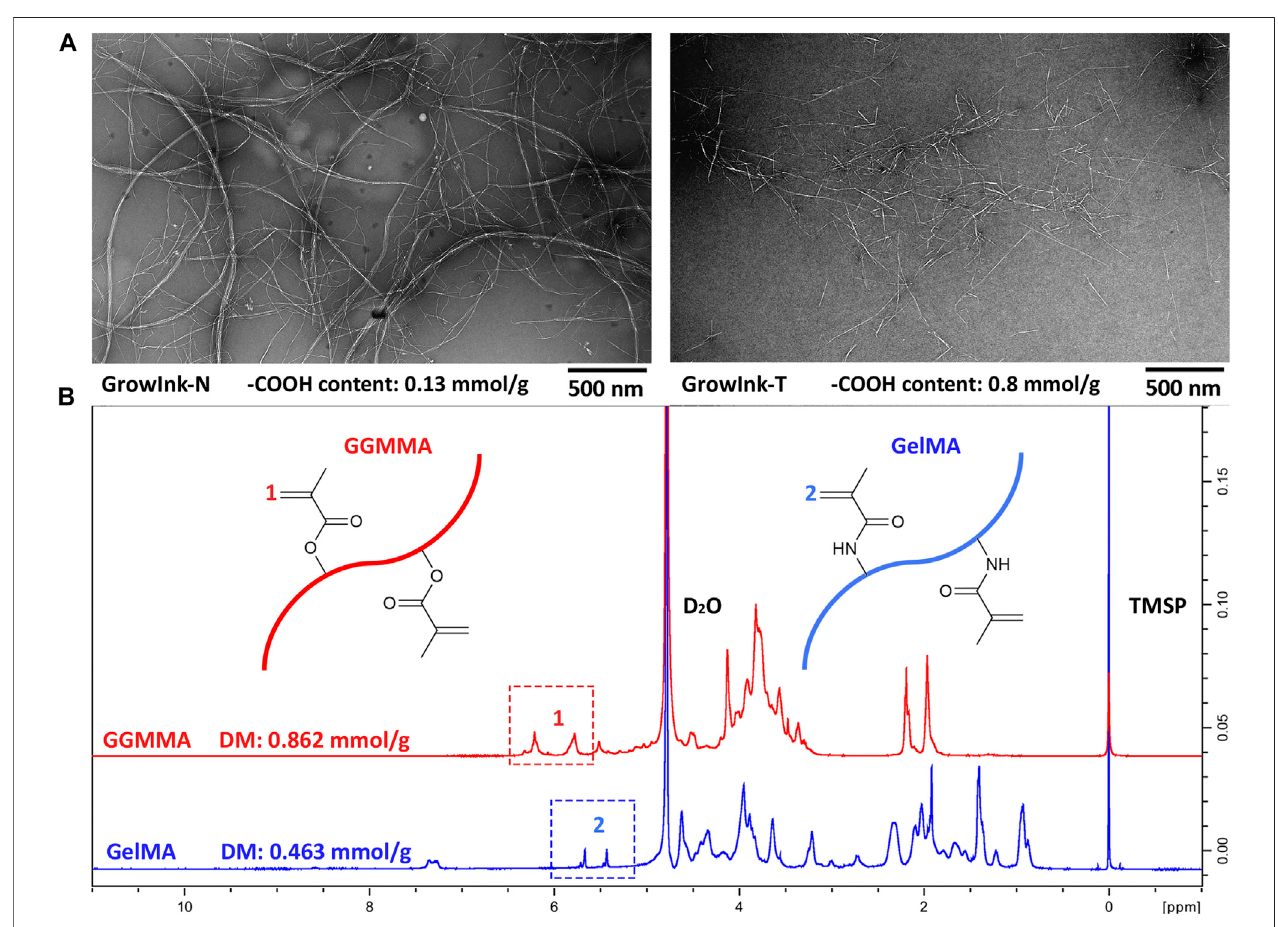
FIGURE 1 | (A) TEM images of GrowInk-N and GrowInk-T and (B) 1 H NMR spectra of GGMMA and GelMA.